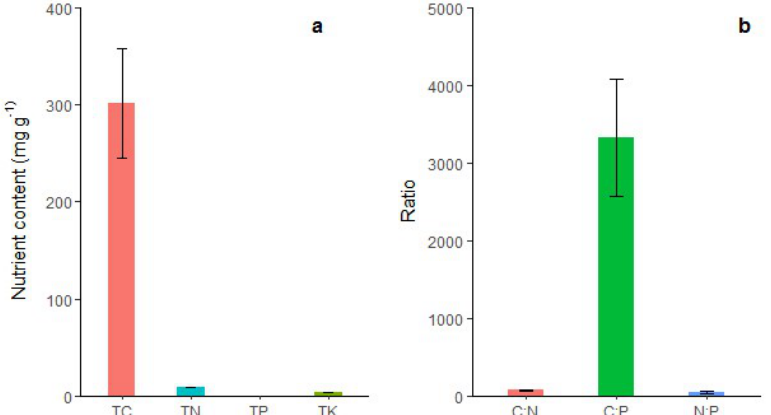
Figure 4. ( a ) Total carbon (TC), total nitrogen (TN), total phosphorus (TP), total potassium (TK); and